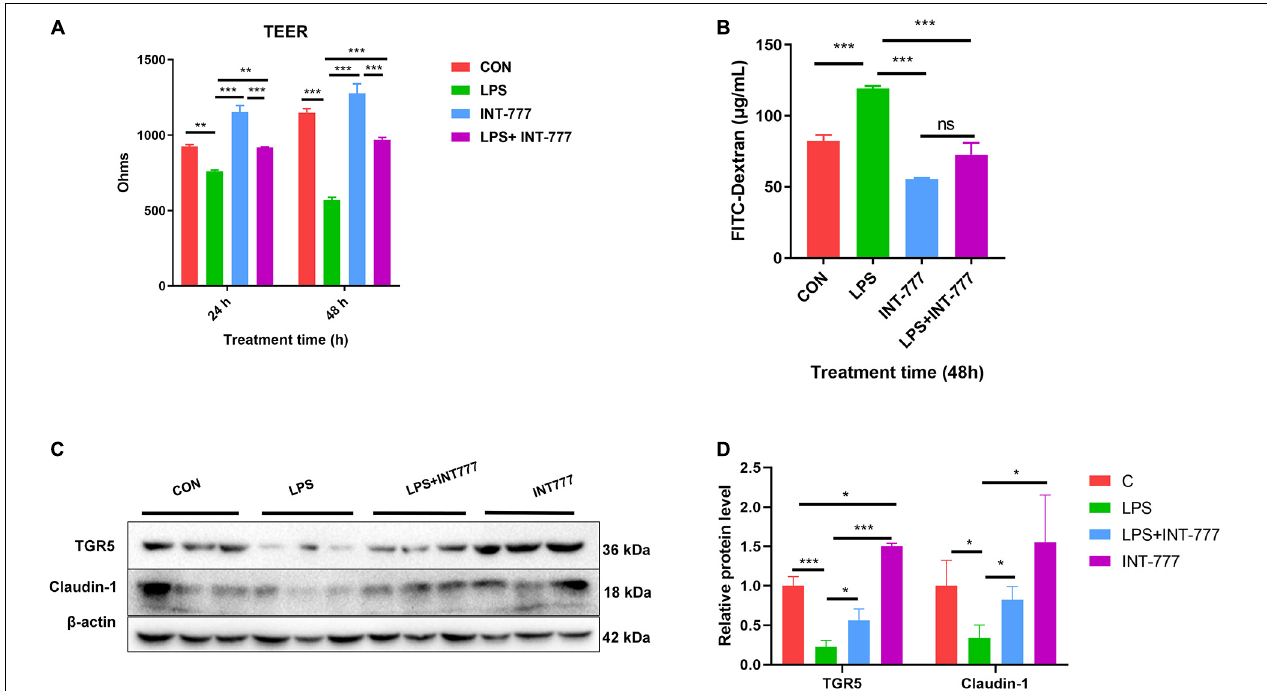
FIGURE 6 | Activation of TGR5 can alleviate LPS-induced epithelium barrier injury of Caco-2 cell. (A) The TEER of the cell monolayer of Caco-2, n = 3. (B) The FITC-dextran permeability of the cell monolayer of Caco-2, n = 3. (C,D) Protein expression of TGR5 and Claudin-1 relative to β -actin. The results were confirmed by three independent experiments. Differences in data in cell subjects were assessed by one-way ANOVA. * p < 0.05; ** p < 0.01; *** p < 0.001.